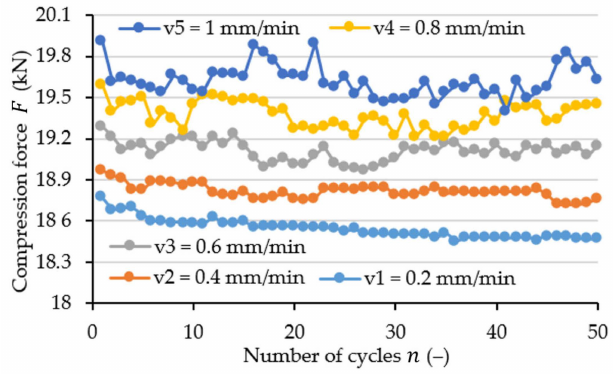
Figure 8. Change in the maximum value of the recorded force for different compression velocities and strain amplitude of ε 01 = 0.01 (mm/mm).